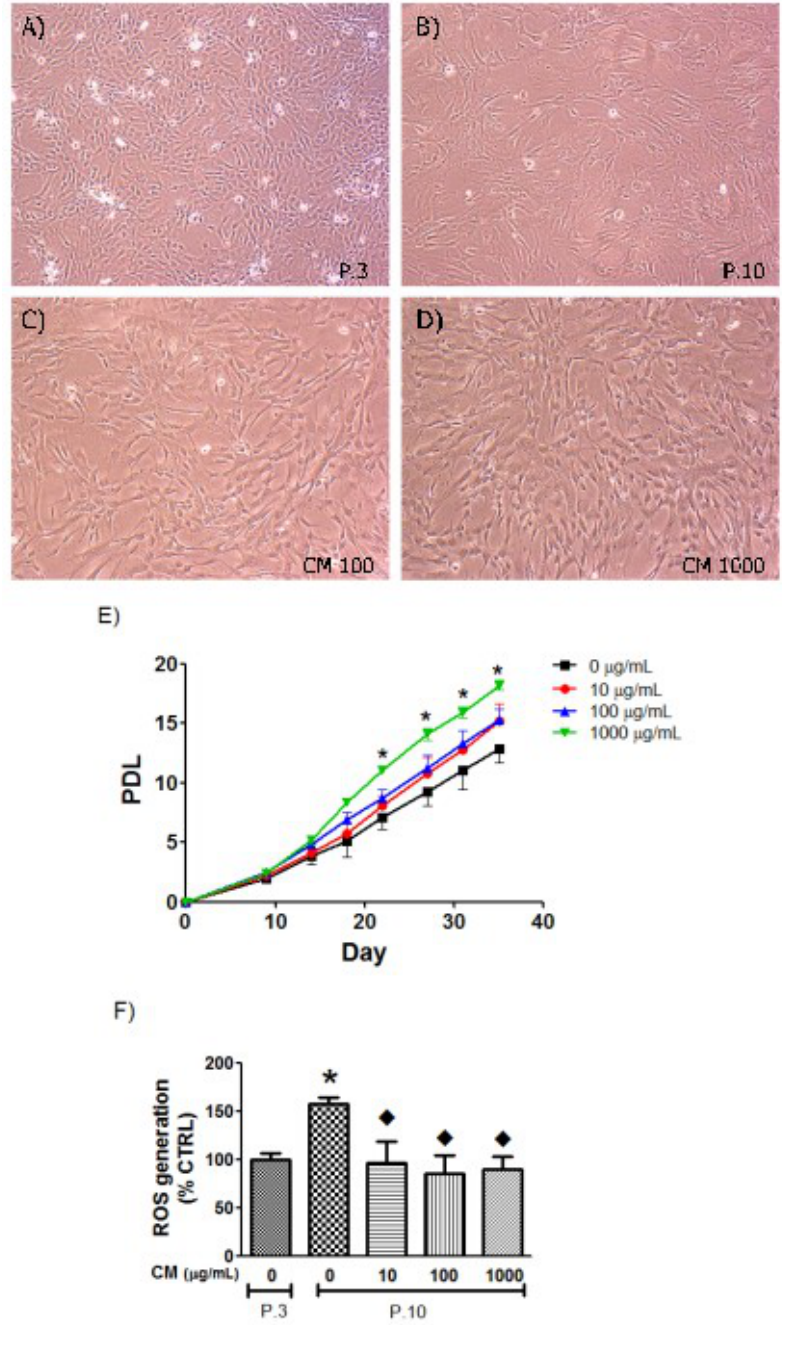
Figure 4. Population doubling level (PDL) of human umbilical vein endothelial cell (HUVECs). Representative photographs of HUVEC morphology at different passages (40× objective lenses): ( A ) HUVECs Passage 3 (P.3); ( B ) HUVECs Passage 10 (P.10); ( C ) HUVECs P.10 with long-term treatment of CM 100 0 μg/mL); ( D ) HUVECs P.10 with long-term treatment of CM 1000 μg/mL); ( E ) Cumulative PDL up to day 35; ( F ) Intracellular reactive oxygen species (ROS) level of HUVECs comparing P.3, P.10 and P.10 with long-term CM co-culture. * p < 0.05, P.3 vs. P.10 non-treated groups (0 μg/mL);  , p < 0.05, P.10 non-treated group vs. P.10 treated with CM 1000